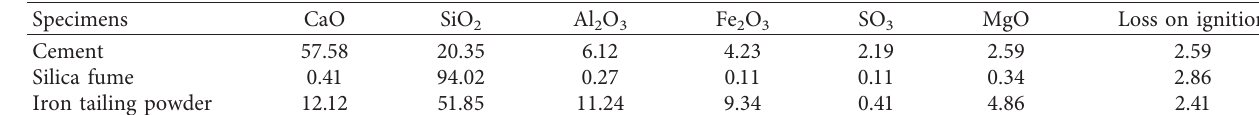
Table 2: Composition analysis of raw materials (%).